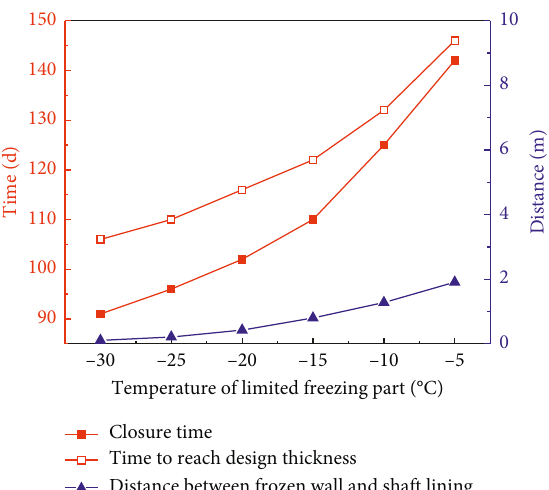
Figure 17: Effect of insulation performance of the differential freezer on the development of the frozen